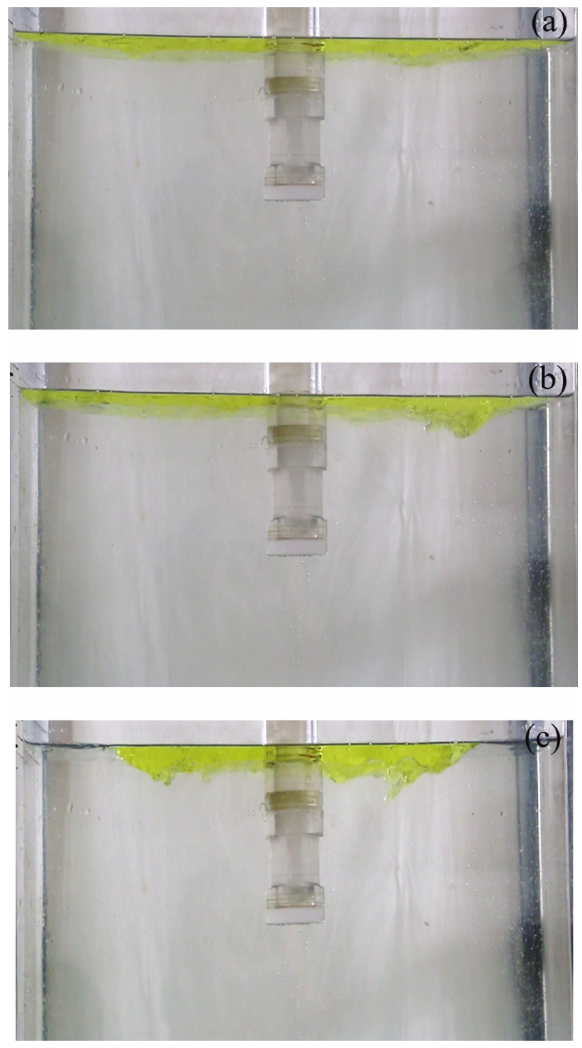
Figure 9: Experiment observation of the slag profiles and the water- oil interface at different casting speeds: (a) 0.9m/min, (b) 1.3m/ min, and (c)